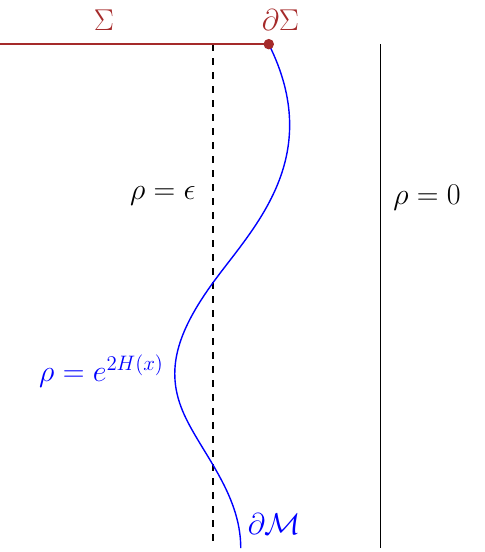
Figure 1 . Schematic representation of the gravitational setup. The manifold M under consideration is bounded by a cutoff boundary surface ∂ M close to spatial infinity ( ρ = 0 ), and by potential Cauchy surfaces Σ . The cutoff surface at ρ = e 2 H ( x ) is the image of the surface at ρ = (cid:15) under a Penrose-Brown-Henneaux